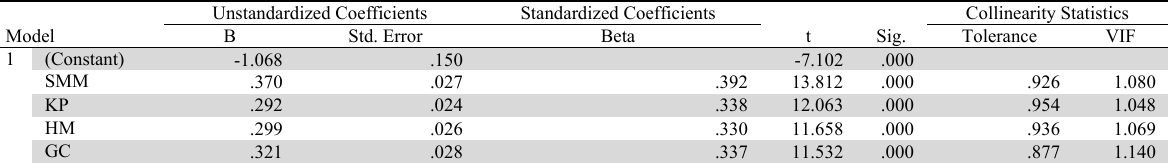
The summary of the regression